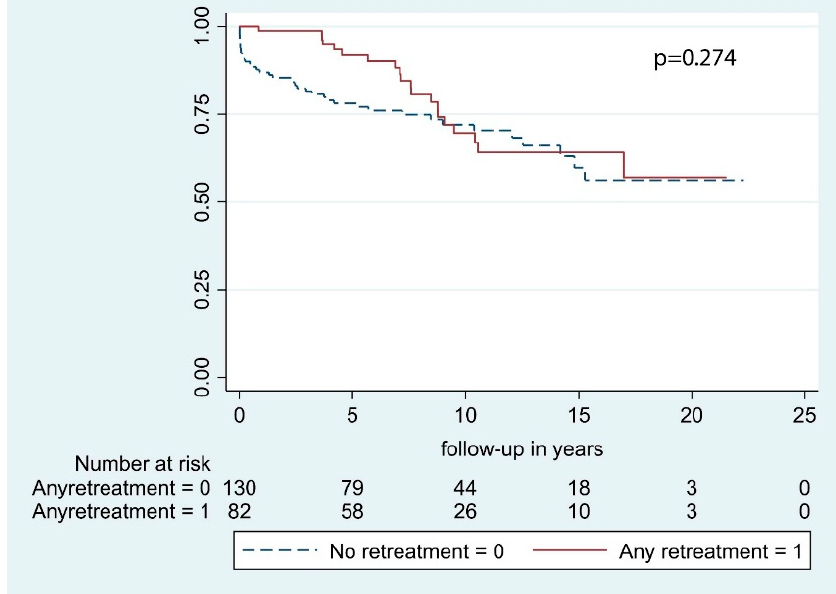
Figure 1. Overall survival by retreatment. According to our univariate analysis, the following predictive factors were signifi- Table 2. Clinical outcomes. cant for OS: Sex, age at primary surgery, and preoperative KPS. Conversely, neurological deficits at presentation, tumor location, and bony invasion had no significant impact on OS (Table 3). In multivariable analysis, only age at primary surgery and KPS were significant with p <0.001 and p = 0.001, respectively (Figures 2 and 3). According to multivariable analysis, patients with poor KPS had more than 6 times the risk of developing a postop- erative hematoma requiring surgical evacuation (OR = 6.2 [1.1–34.6], p = 0.039), whereas no significant correlation with worsened neurological outcome ( p = 0.182), postoperative infections ( p = 0.987), or 30-day mortality ( p = 0.318) was found.